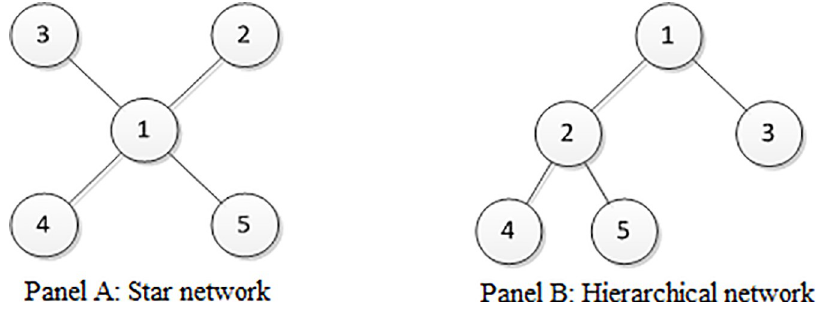
Fig 1. Two basic network structures.